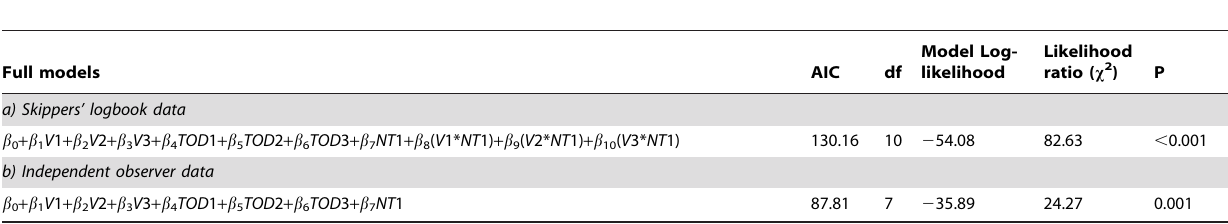
Table 4. Summary of full models to predict dolphin bycatch by fitting multiple factors for a) skippers’ logbook data and b) independent observer data.